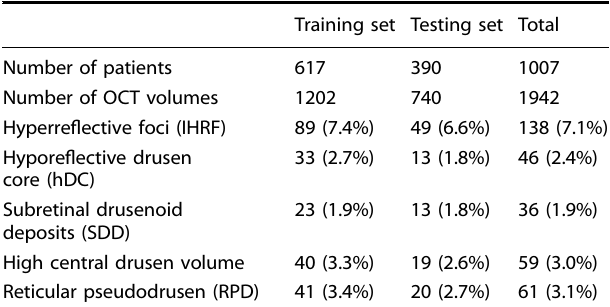
Table 2. The biomarkers used for this study and their prevalence throughout the three